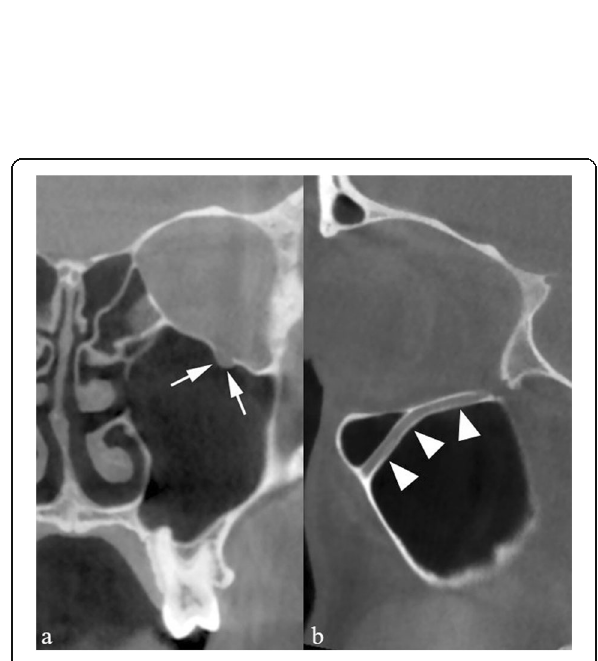
Fig. 14 Anatomical variant of nerve course. Coronal CBCT reformation ( a ) showing dehiscence of the bony walls of the infraorbital canal (arrows) and minor protrusion of the nerve within the maxillary sinus; sagittal CBCT reformation ( b ) showing the nerve hanging in the maxillary sinus cavity (arrowheads), covered by intact nerve canal